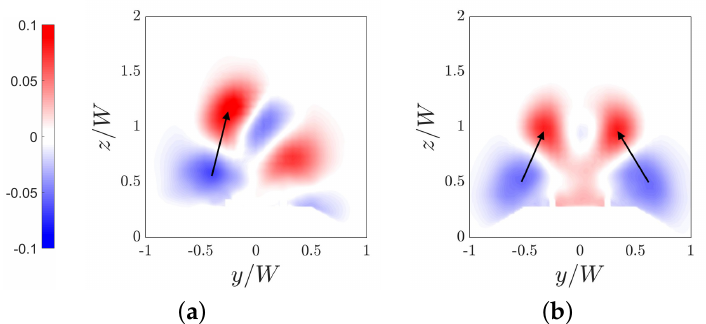
Figure 7. Nondimensionalised mean slipstream velocity differential for ( a ) parallel fins and ( b ) cir- culation injection at a downstream distance of 3 L Ref , with arrows indicating key shifts from the baseline